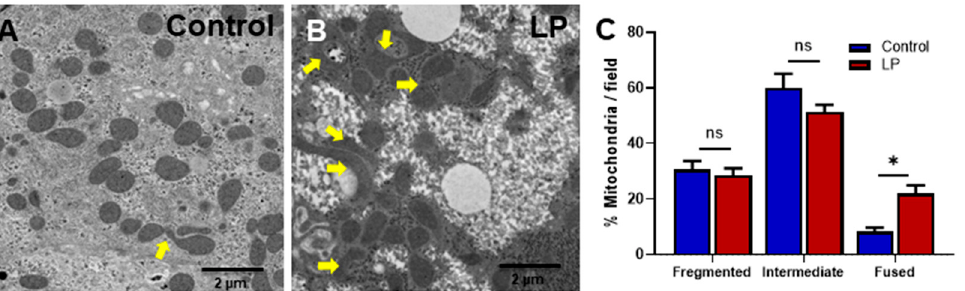
Figure 1. Transmission electron microscopic images of hepatocytes illustrating the variation in the mitochondrial structure in the control vs. LP programmed female rats. ( A ) Ultrastructure of mito- chondria in the hepatocytes of the control and ( B ) LP programmed lean diabetic rats. ( C ) Percentage of fragmented, intermediate, and fused mitochondria per field in the control and LP rats (* p < 0.05, ns—not significant); n = 3 per group.